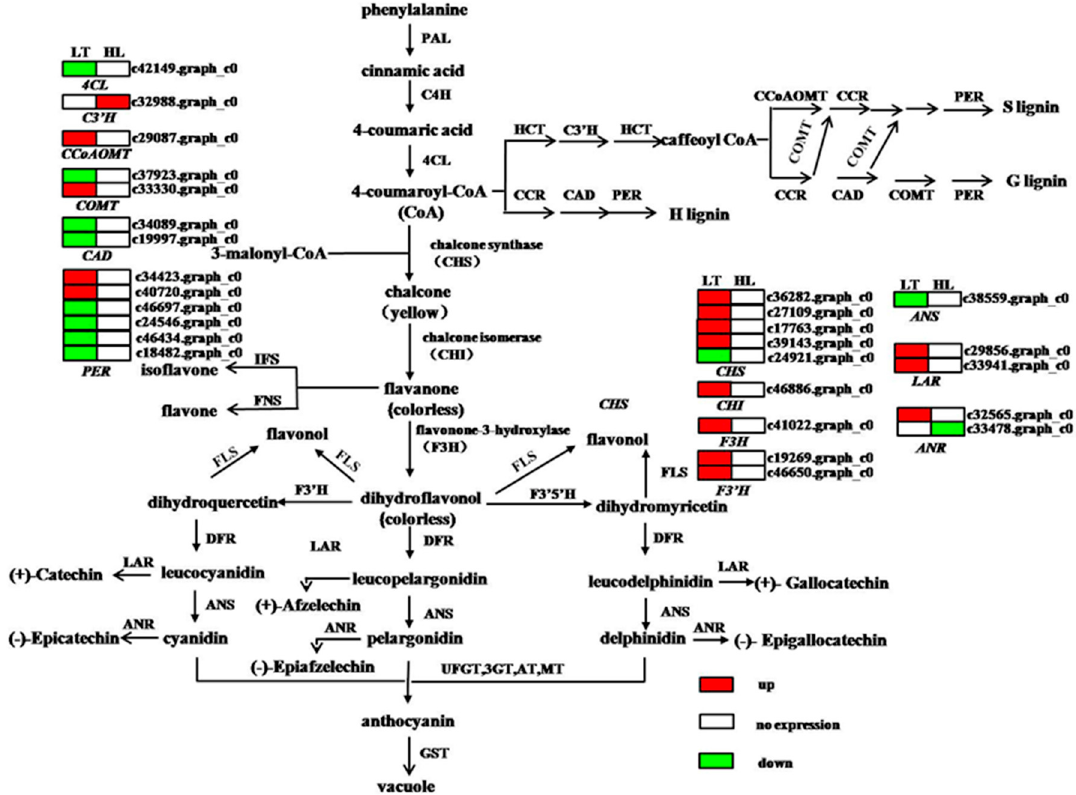
Figure 5. Schematic of physiological and the expression of differentially expressed genes (DEGs) regulated only by LT or HL condition in phenylpropanoid and flavonoid biosynthesis in B.